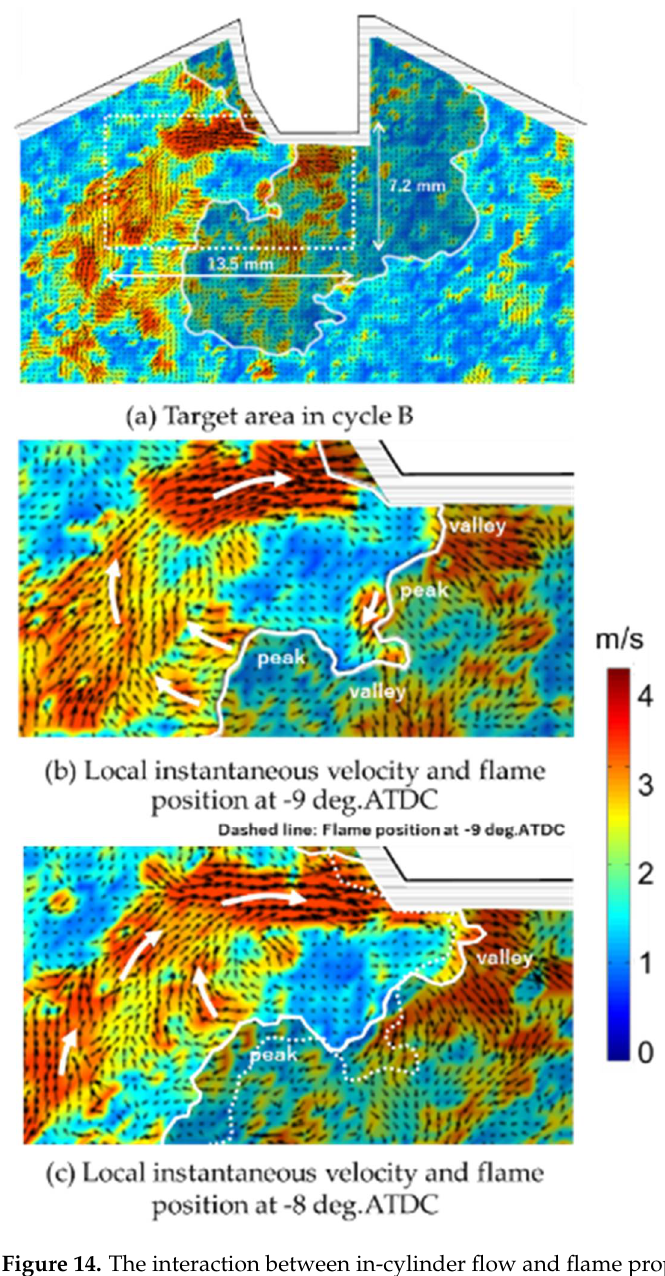
Figure 14. The interaction between in-cylinder flow and flame propagation in cycle B. ( a ) The high turbulence area is highlighted and enlarged at ( b ) −9deg.ATDC and ( c ) −8deg.ATDC.